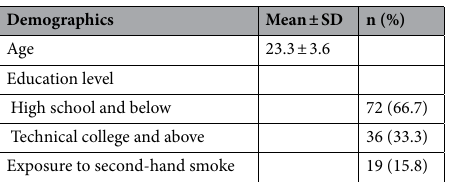
Table 1. Female volunteer soldier demographics (N = 120).